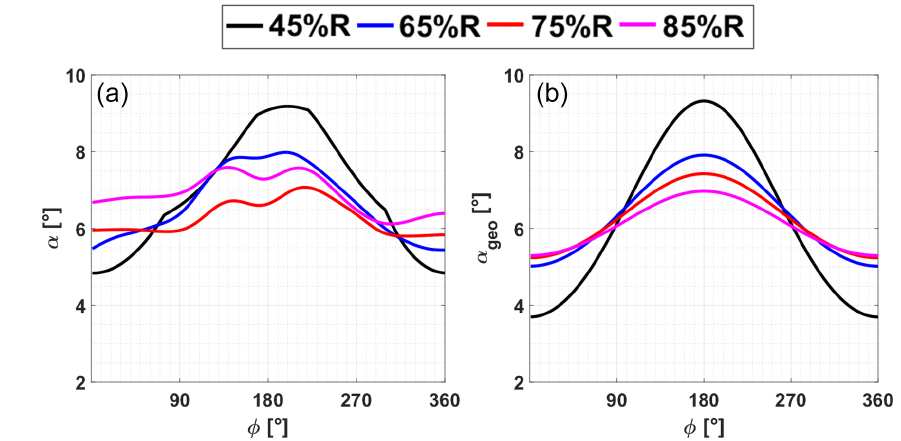
Figure 15. AoA results for yaw angle ψ = − 15 ◦ and pitch angle θ = 0 ◦ . Pressure taps and three-hole-probe approaches (a) . Analytical calculations (b) .